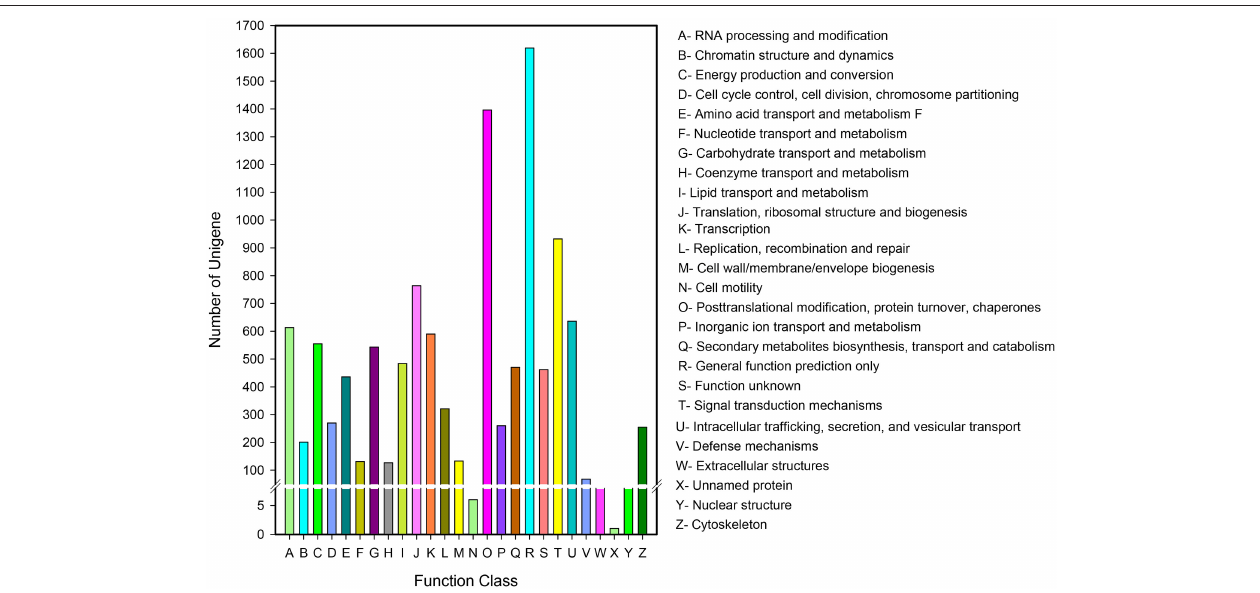
FIGURE 5 | KOG function classification of D. asperoides . All the unigenes were aligned to the KOG database to predict and classify possible functions. A total of 10,056 unigenes were clustered into functional